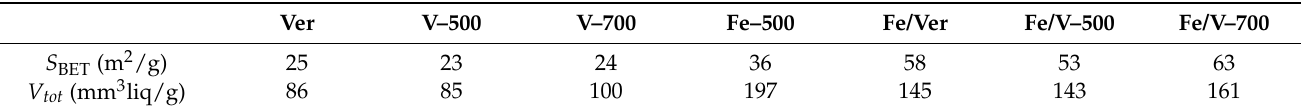
Table 4. Textural properties S BET and V tot of vermiculites, α -Fe 2 O 3 nanoparticles and α -Fe 2 O 3 nanoparticles/vermiculite composites.